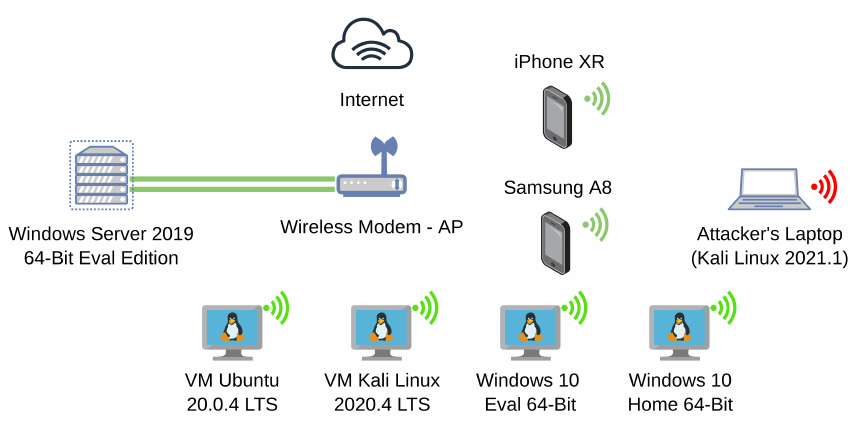
Figure 1. High-level view of the testbed network topology. The MS Windows Server 2019 uses a wired connection with the AP, presented as a double green line. The network traffic flow for disparate categories of VM and physical stations is shown in a different color, namely green for Wi-Fi traffic and red for the